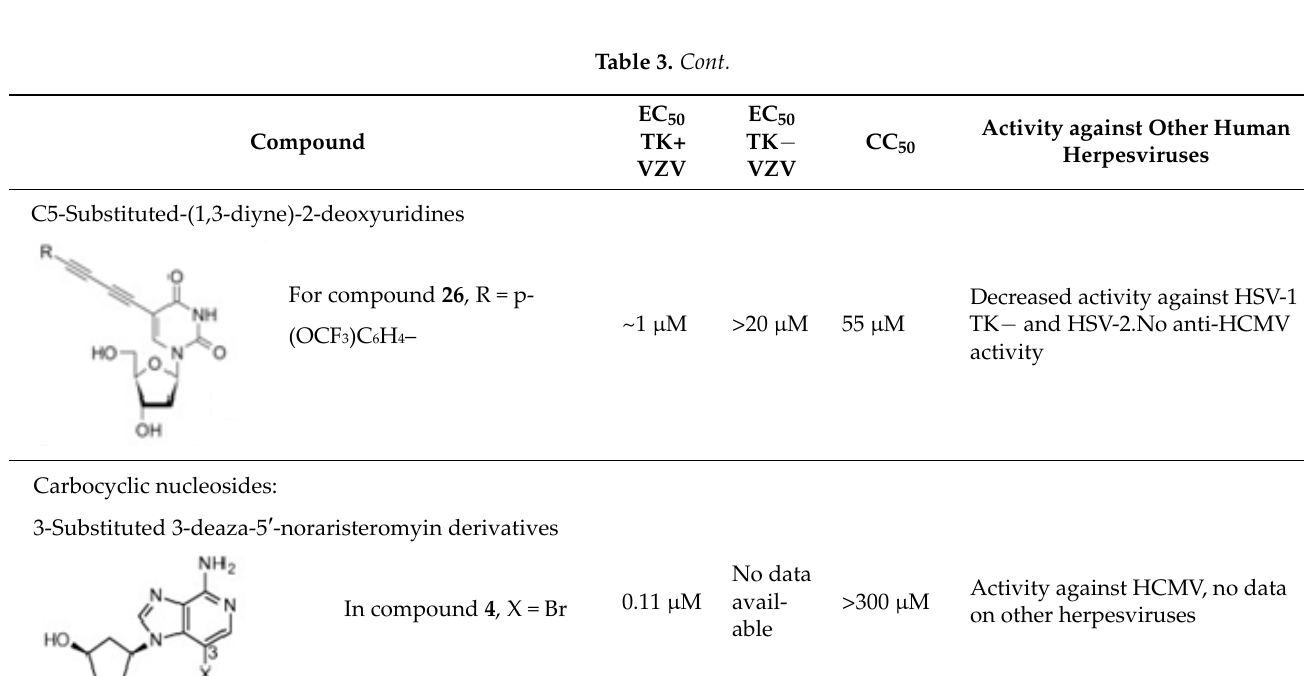
19 of 35 Table 3. Candidate anti ‐ VZV drugs . Compounds described in the last years showing promising activity against VZV. Compound